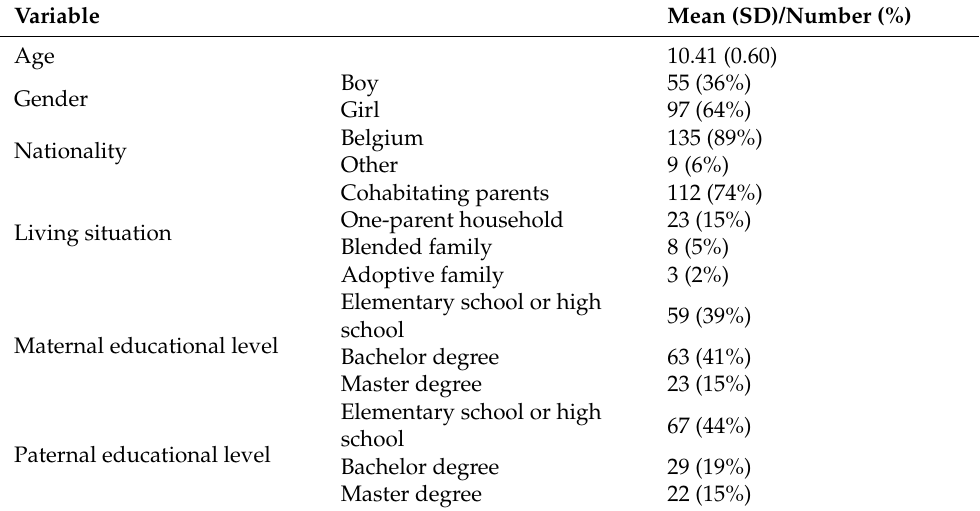
Table 1. Participant characteristics at time